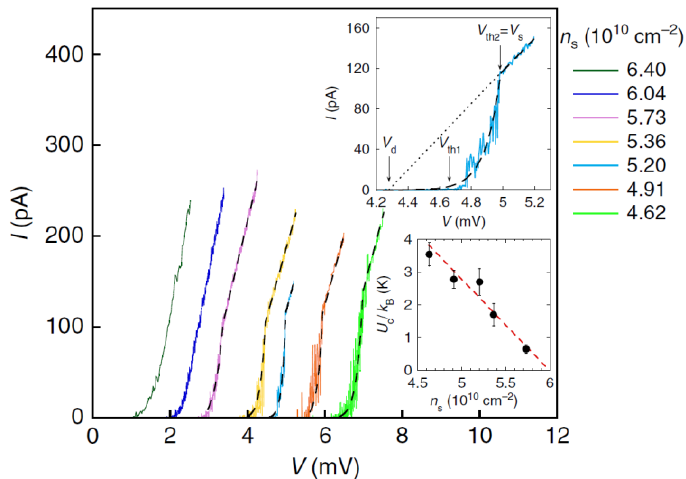
Figure 7. Voltage-current characteristics of 2D electrons in a Si-metal-oxide-semiconductor field-effect transistor (Si-MOSFET) in a possible Wigner crystal (WC) state. V-I curves of different electron densities are shown to show the depinning of the WC. Figure taken from Reference [35].